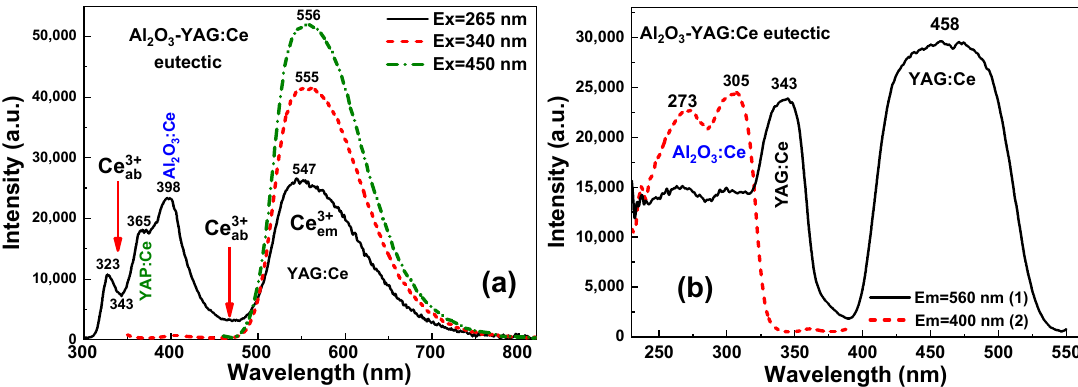
Figure 7. PL emission spectra ( a ) and PLE spectra ( b ) of (Al 2 O 3 -YAG):Ce eutectic (sample 4) under excitation at different wavelengths ( a ) and registration of Ce 3+ luminescence in the garnet (( b ), curve 1) and sapphire phase (( b ), curve 2).